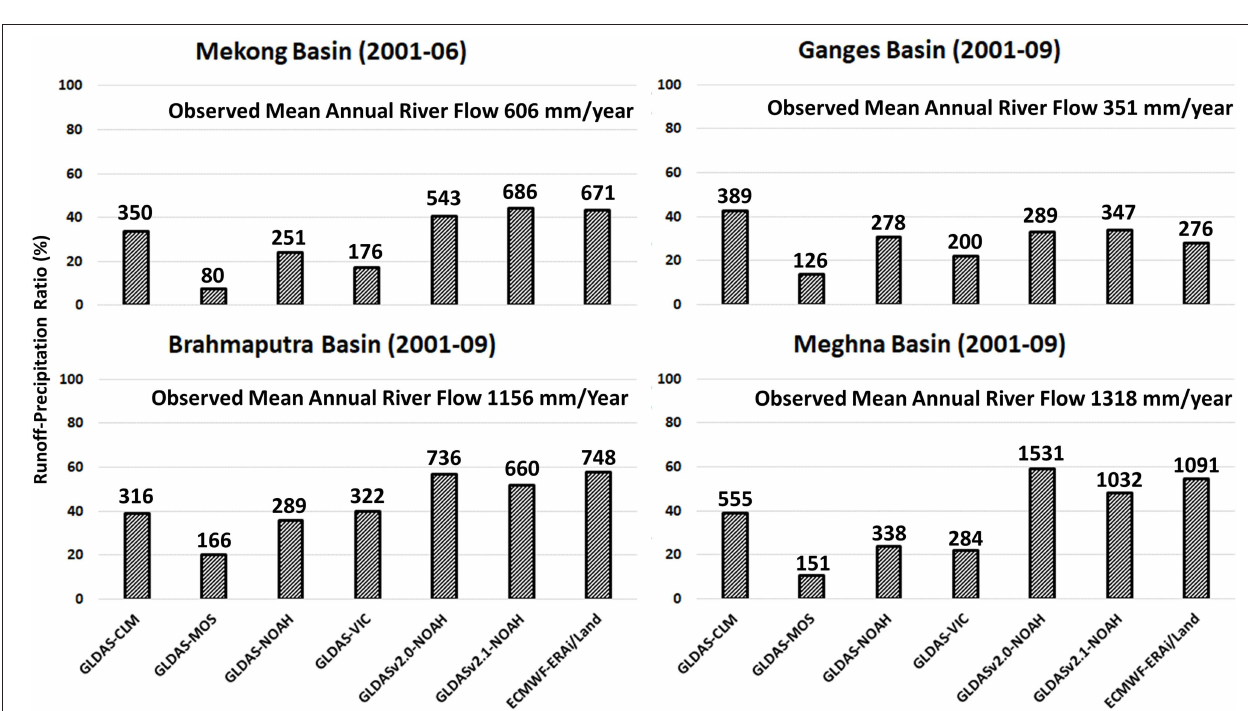
FIGURE 3 | Mean annual Runoff-Precipitation ratio of the Mekong and GBM basins, along with the observed mean annual river flow. All the values reported above the bars are the simulated mean annual runoff in mm. Analysis for Mekong basin was conducted up to 2006, constrained by the in-situ river flow data availability.